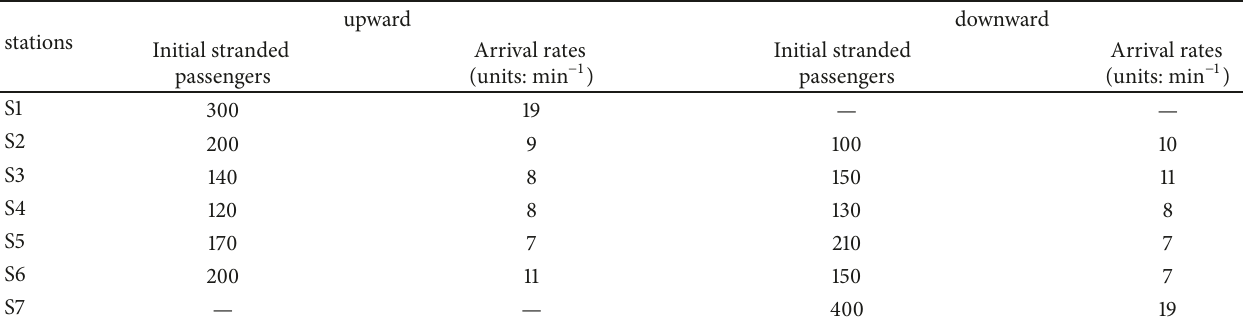
Table 2: Passengers flow demands in the numerical case.